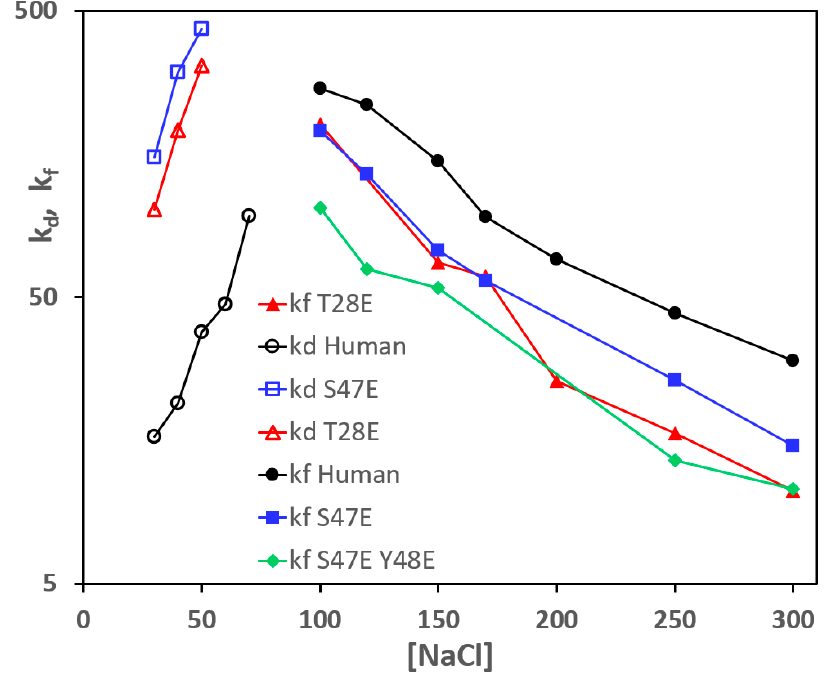
Figure 6. Laser-induced electron transfer from native human Cc wild type, T28E, and S47E and S47E-Y48E mutants to bovine CcO. The k d and k f values of the human Cc mutants were measured using the lumiflavin laser flash photolysis method as described in the text. k d is in s − 1 , while k f is in μ M − 1 s − 1 . The samples contained 10 μ M human Cc, 5 μ M bovine CcO in 5 mM sodium phosphate, pH 7.0, 0.1 % lauryl maltoside, 100 μ M lumiflavin, 0.5 mM EDTA and the indicated concentrations of NaCl.